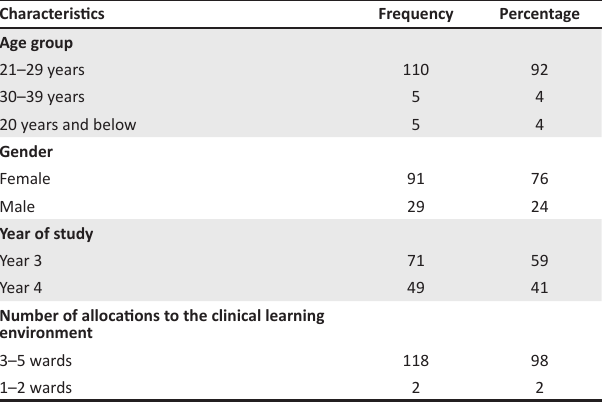
TABLE 1: Demographic characteristics of participants.